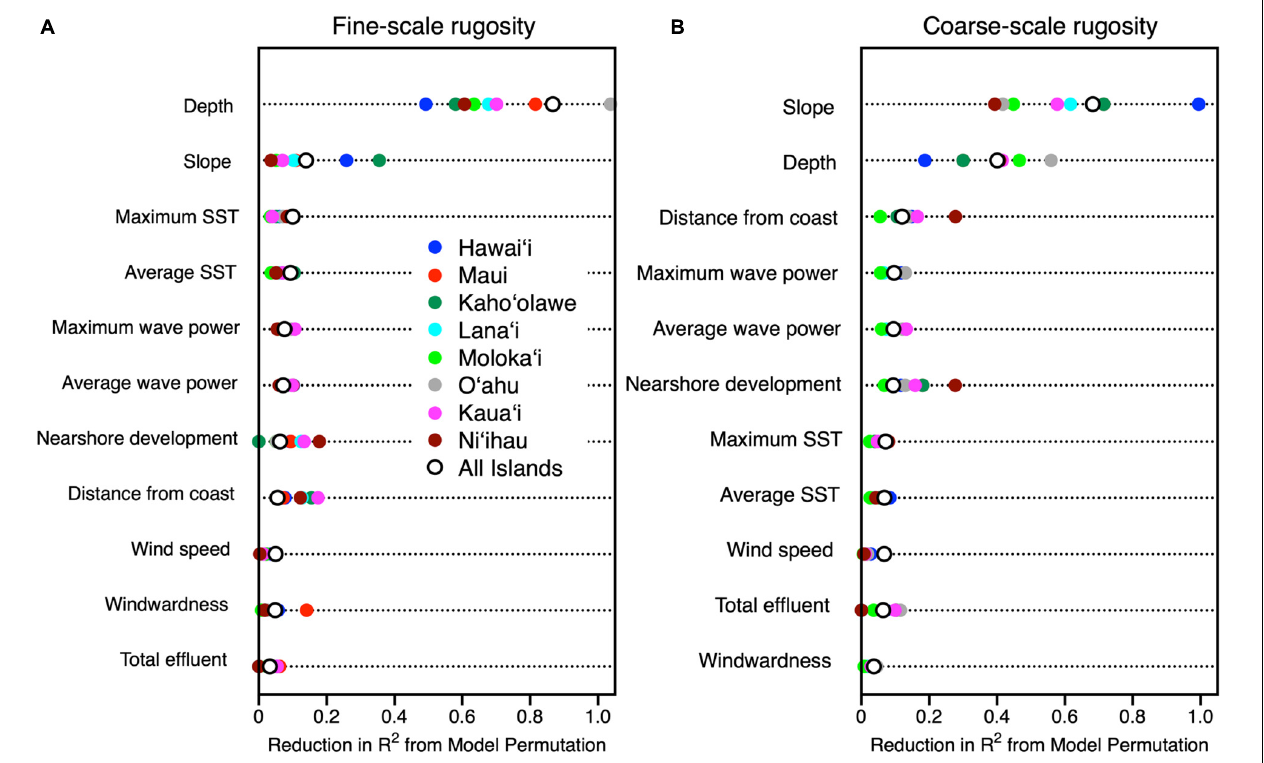
FIGURE 6 | Relative importance of potential contributing variables evaluated using machine learning to drive spatial variation in (A) fine-scale and (B) coarse-scale reef rugosity throughout the eight Main Hawaiian Islands. Colored dots indicate relative importance by island, and open circles indicate relative importance for all islands